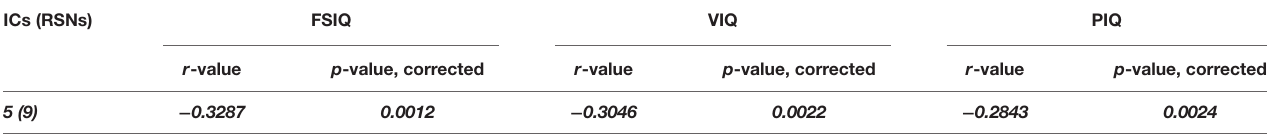
TABLE 4 | Correlation between degree values of the identified IC and IQ scores.